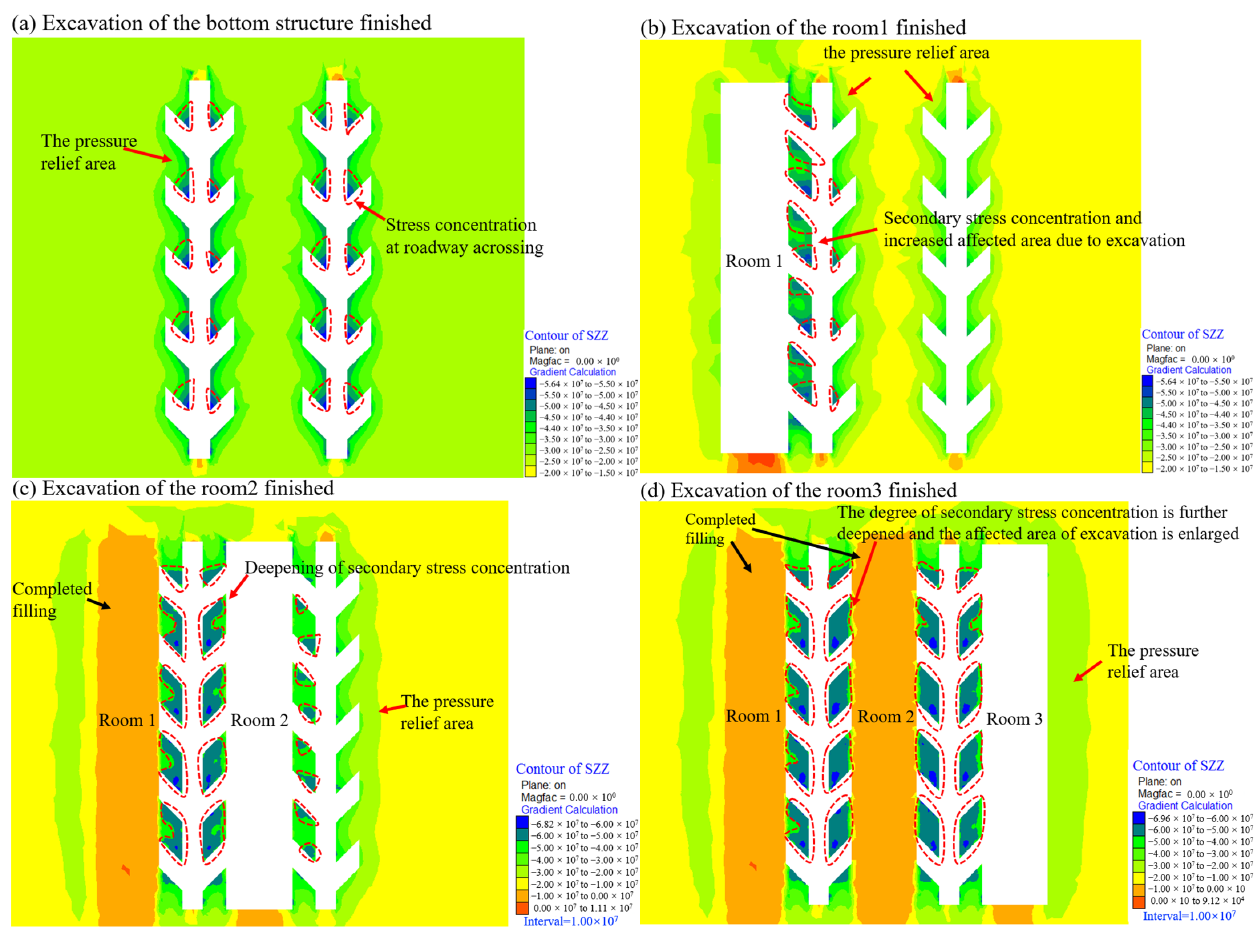
Figure 4. Stress distribution of bottom structure. ( a ) Excavation of the bottom structure finished ( b ) Excavation of the room 1 finished ( c ) Excavation of the room 2 finished ( d ) Excavation of the room 3 finished.